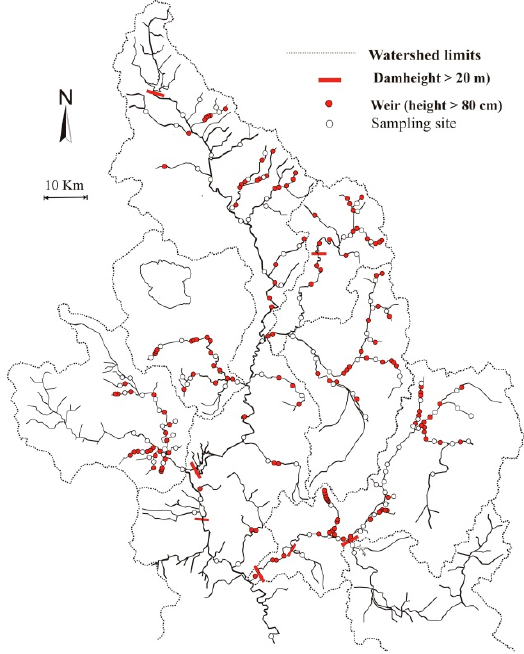
Figure 9. Weirs and dams’ locations in the study area.